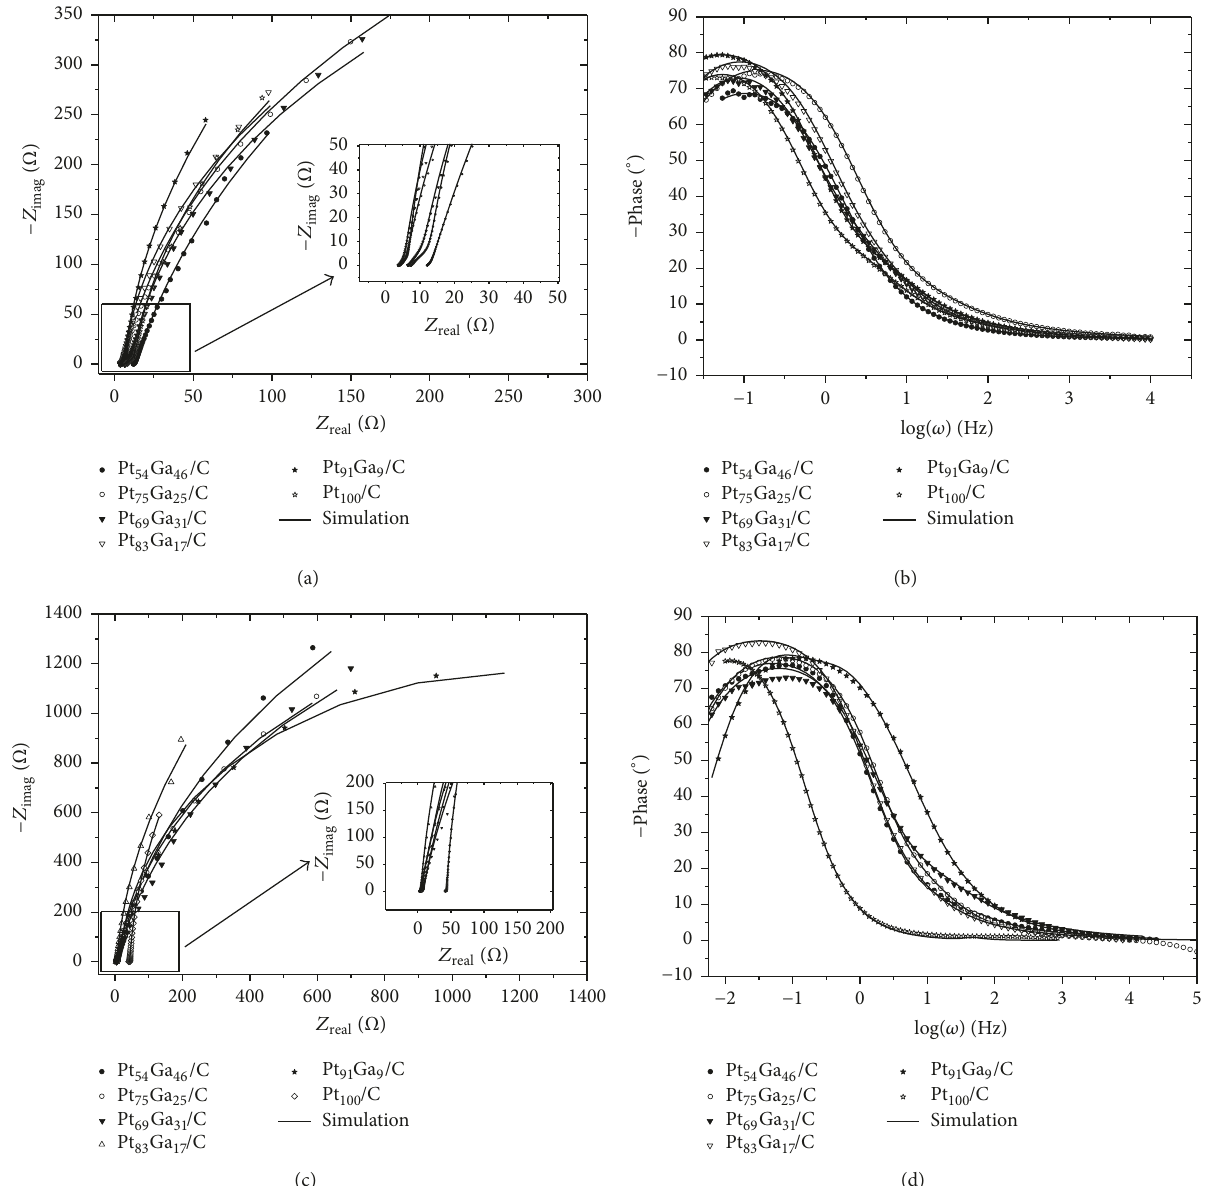
Figure 10: Nyquist ((a) and (c)) and Bode ((b) and (d)) plots of the PtGa/C electrocatalysts in ((a) and (b)) ethanol 1.0 molL −1 in supporting electrolyte solution and ((c) and (d)) only supporting